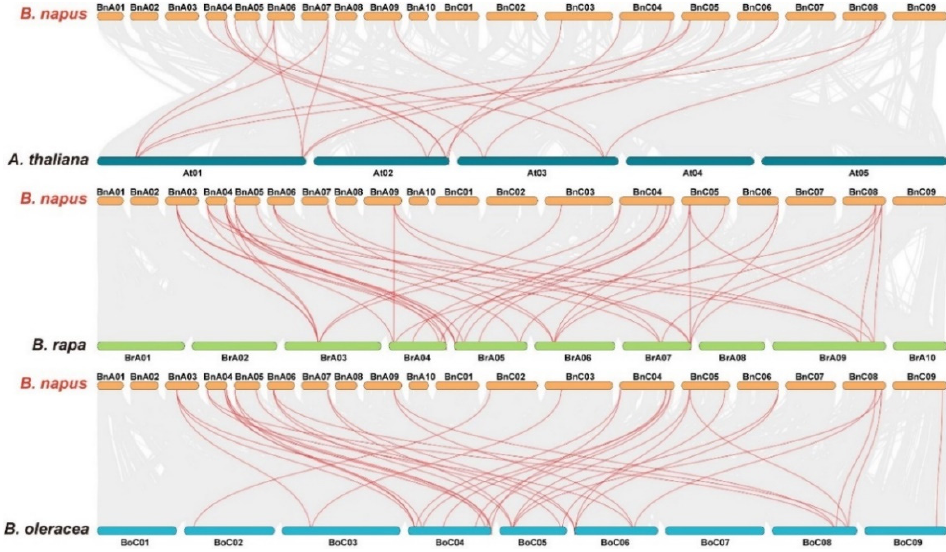
Figure 6. Synteny analysis of MTP genes in B. napus and three ancestral plant species. Gray lines in the background indicate the collinear blocks within B. napus and other plant genomes, while the red lines highlight the syntenic MTP gene pairs.